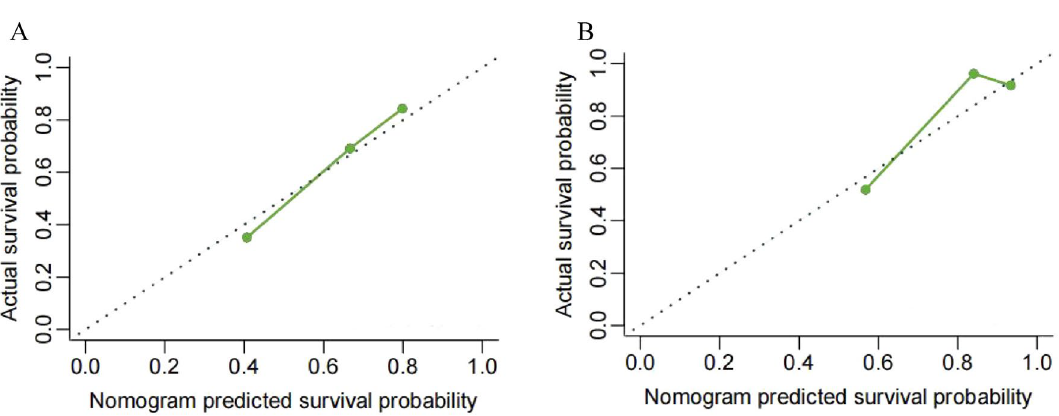
Figure 5. Calibration curves of the nomogram to predict the patients most likely to benefit from surgery in the SEER ( A ) and the Chinese cohorts ( B